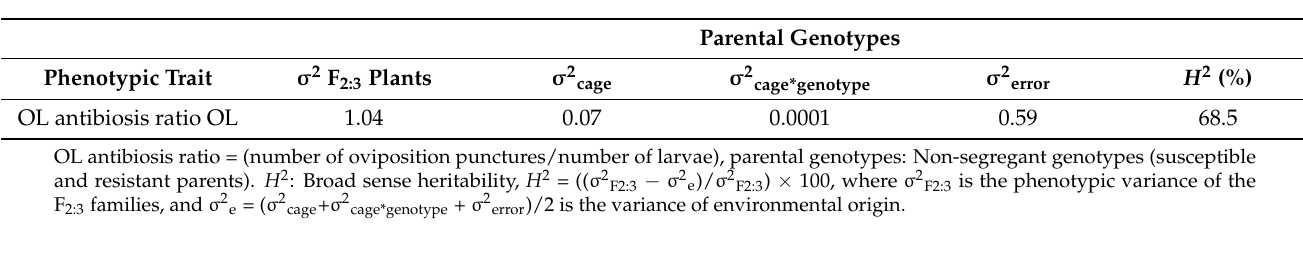
Table 4. Broad sense heritability percentages using the σ 2cage and σ 2cage*genotype variance components from F 2:3 K07-1544/PI165673 families and parental genotypes infested with Dectes texanus in 2012. Phenotypic Trait